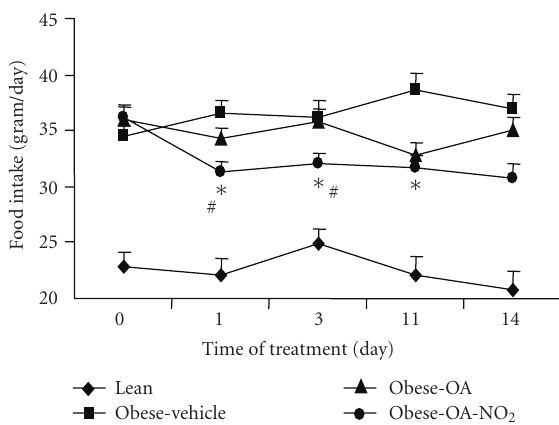
Figure 1: Food intake in male 4-mo-old obese Zucker rats (obese) over 14 days of infusion with vehicle, OA-NO 2 , or OA, each at 7.5 μ g/kg/d via osmotic mini-pumps. Age and gender matched lean rats with vehicle treatment were used as controls. Lean: n = 3; Vehicle: n = 7; OA-NO 2 : n = 5; OA: n = 5. ∗ , P < . 01 versus Obese/Vehicle; # , P < . 05 versus OA during the corresponding period. Data are mean ±